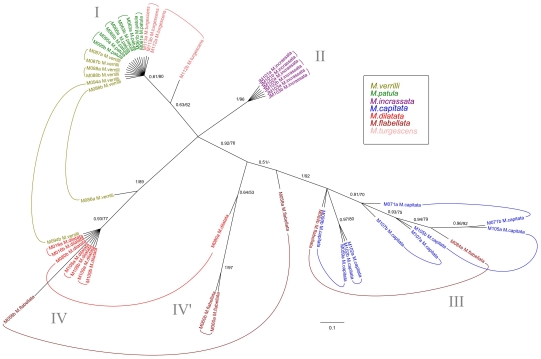
ATPs β haplotypes for Hawaiian Montipora.
Confidence values are BI/ML, and species are color coded by morphospecies identification. Colored lines indicate haplotypes that were inferred from genotypic sequences using Phase [33].